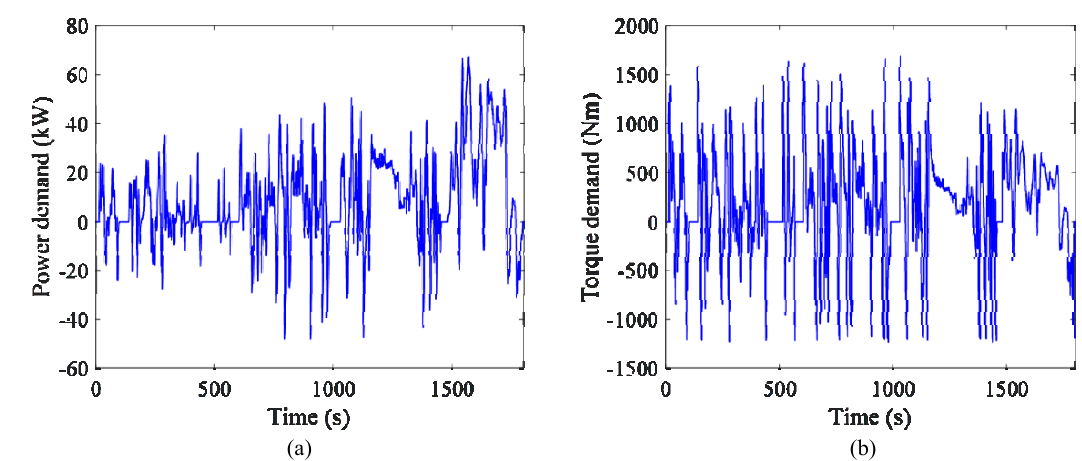
Figure 4. CEM working points. ( a ) Front CEM. ( b ) Rear CEM.